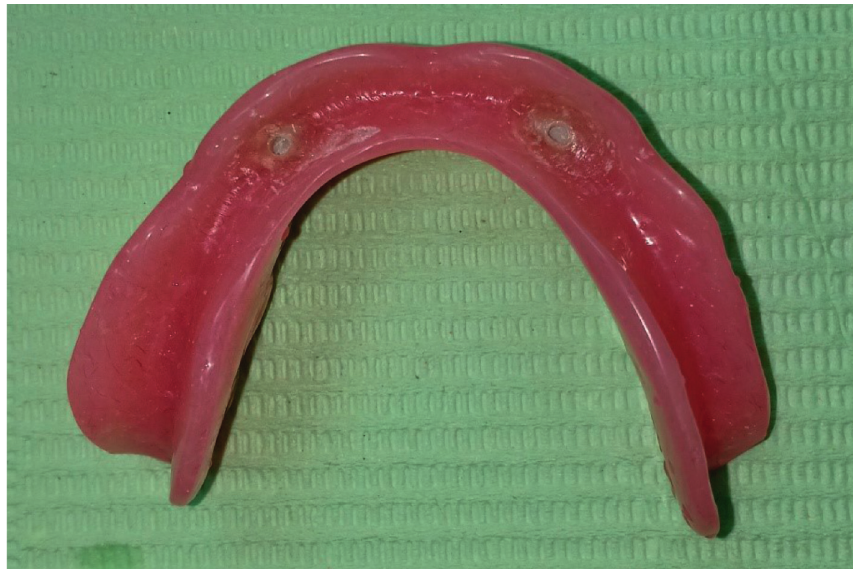
Figure 6: Fitting surface with picked up PEEK